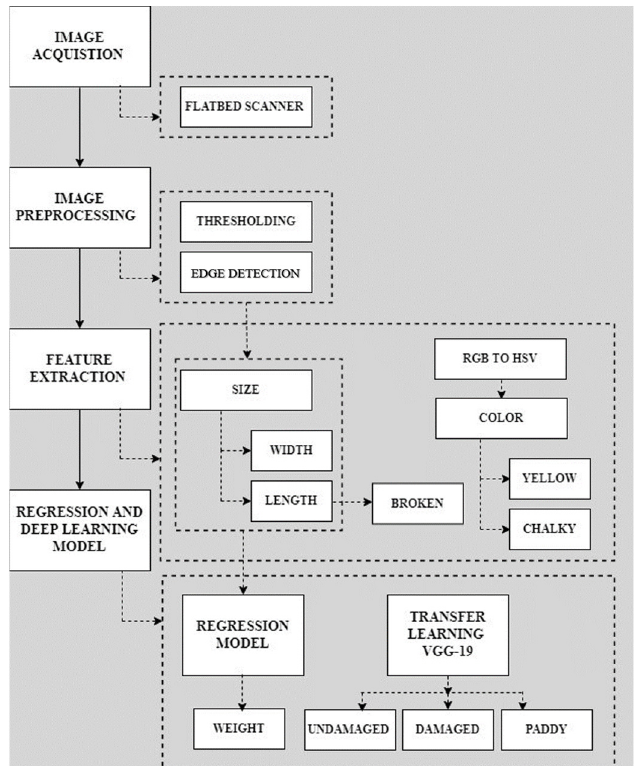
Figure 1. The systems flow diagram.